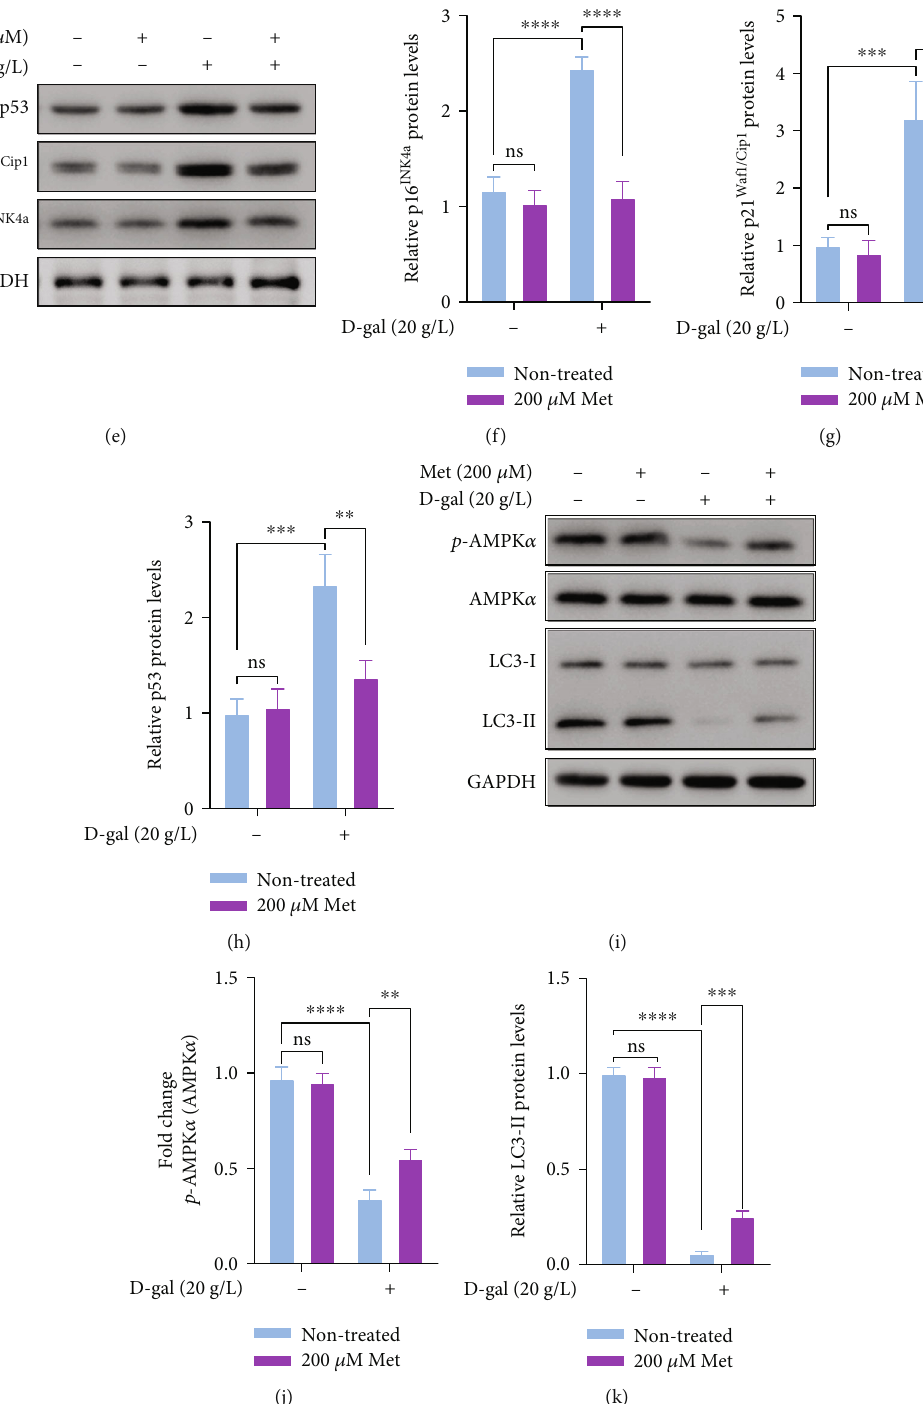
Figure 5: Metformin signi fi cantly ameliorated D-gal-induced senescent hBMSCs, but not unsenescent hBMSCs. (a) Quanti fi cation of intracellular ROS levels by fl ow cytometry. (b) Representative images of SA- β -Gal-positive hBMSCs, scale bar, 100 μ m. (c) Quanti fi cation of MMP by fl ow cytometry. (d) Analysis of cell cycle distribution by fl ow cytometry. (e – h) The expressions of p16 INK4a , p21 Waf1/Cip1 , and p53 proteins were detected by western blot analysis. GAPDH was used as a control. (i – k) The expressions of AMPK α , p-AMPK α , and LC3 proteins were detected by western blot analysis. GAPDH was used as a control. n = 3 for each group. Data shown are mean ± SEM . Analysis of variance (ANOVA). ∗ p < 0 : 05 , ∗∗ p < 0 : 01 , ∗∗∗ p < 0 : 001 , and ∗∗∗∗ p < 0 : 0001 versus the D-gal group; ns: not signi fi